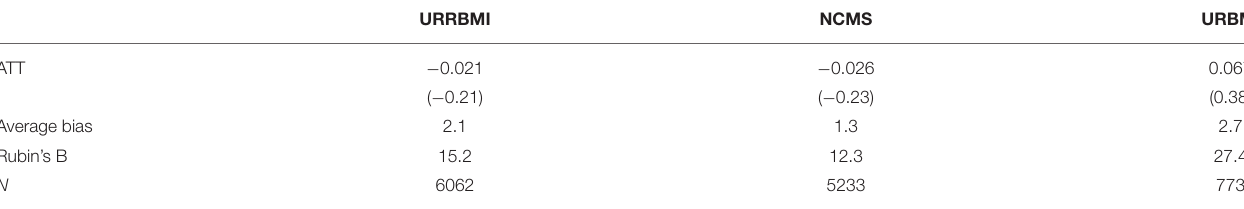
TABLE 9 | PSM estimates of URRBMI on children’s educational outcomes. URRBMI NCMS URBMI ATT −